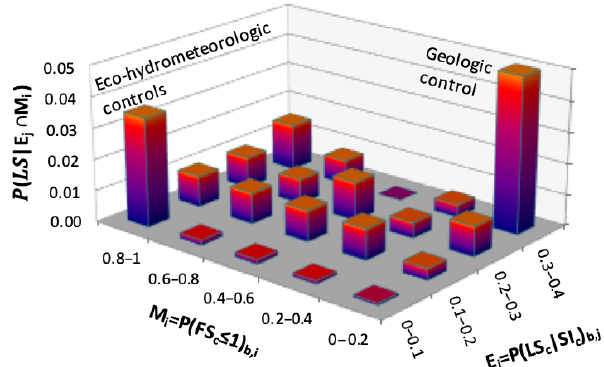
Figure 2. Illustration of the proposed landslide probability con- ditioned on estimated spatially distributed SI-based empirical and modeled probabilities as binned indices E J and M i , which form a joint space. P (LS | E j ∩ M i ) is defined as the ratio of the number of landsliding cells to the number of cells that jointly fall into the given E j and M i